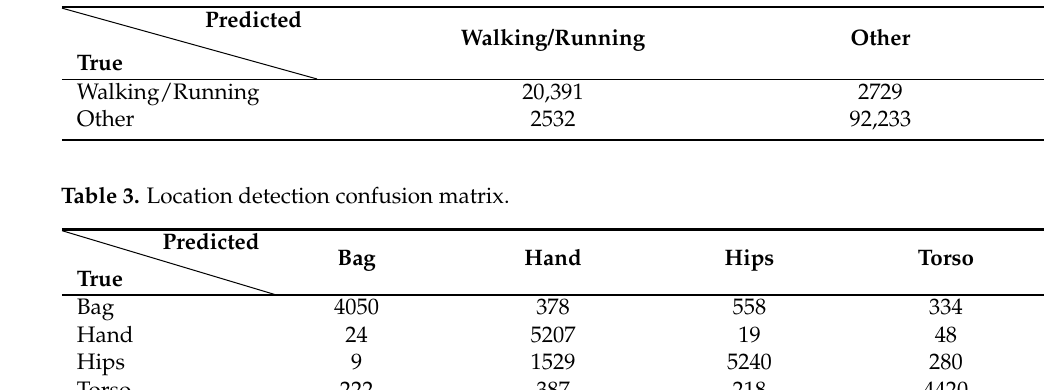
Table 2. Activity recognition confusion matrix.